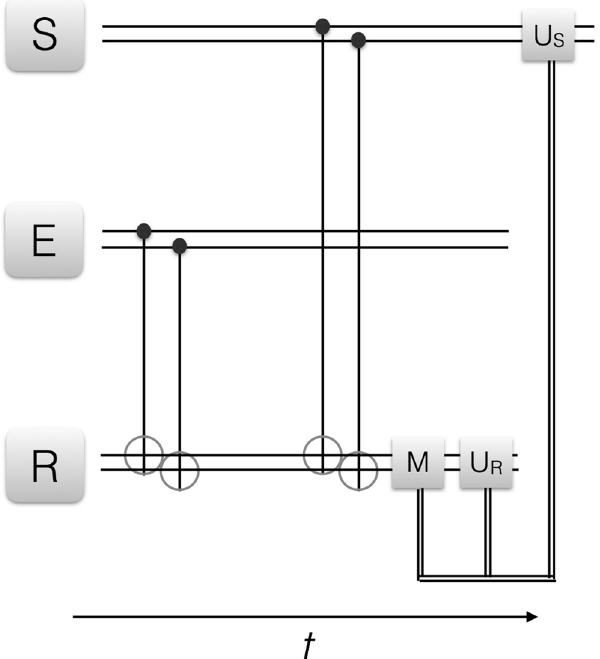
Figure 4. Quantum reinforcement learning for multiqubit system, II. We depict the circuit representation of the proposed learning protocol. S, E and R denote the agent, environment and register two-qubit states, respectively. CNOT gates between the respective pairs of qubits in E and R as well as in S and R are depicted with the standard notation. In this case, the measurement M acts on both register qubits, and is performed in the computational basis chosen. U S and U R are local operations on agent and register, respectively, conditional on the measurement outcomes via a classical feedback loop. The double narrow lines denote classical information being fedforward, while the horizontal, double wider lines denote two-qubit states. The protocol can be iterated upon changes in the environment via reset of the